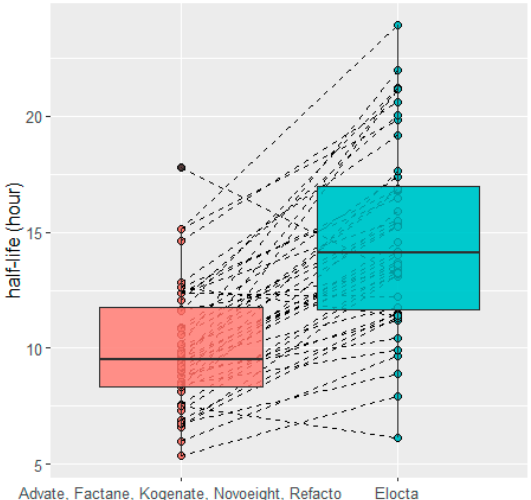
Figure 6. Half-life comparison before and after switching from Advate, Factane, Kogenate, Novoeight, or Refacto to Elocta.